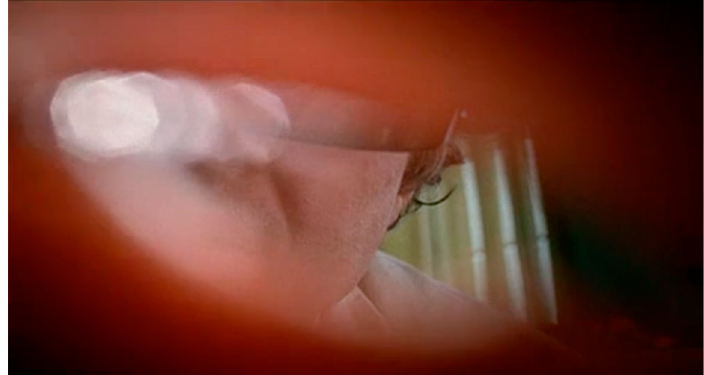
Figure 22. Image from The Diving Bell and Butterfly (2007) [34].